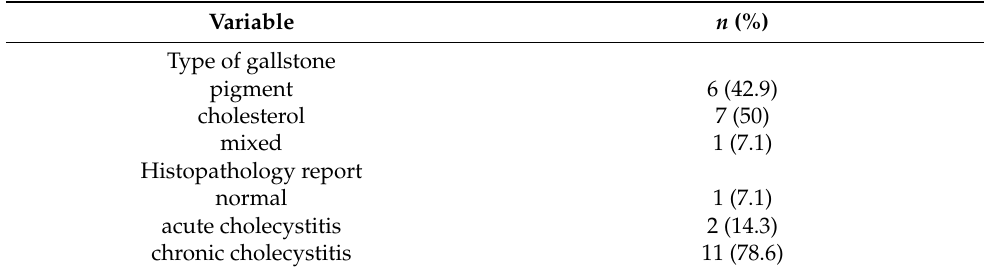
Table 3. Spectrophotometric analysis of gallstones and histopathology report of children who underwent